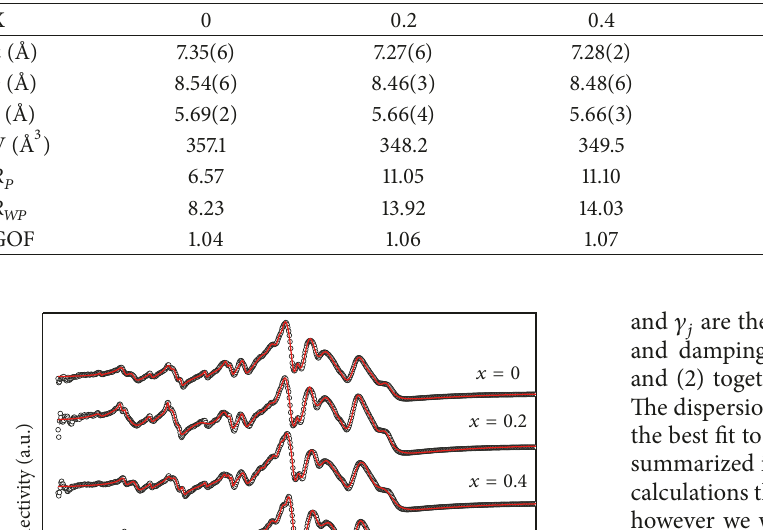
Table 1: Summary of lattice parameters and refinement data for Gd 1−𝑥 Y 𝑥 Mn 2 O 5 .